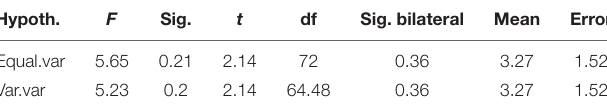
TABLE 4 | Independent sample testing (post-test). Hypoth.